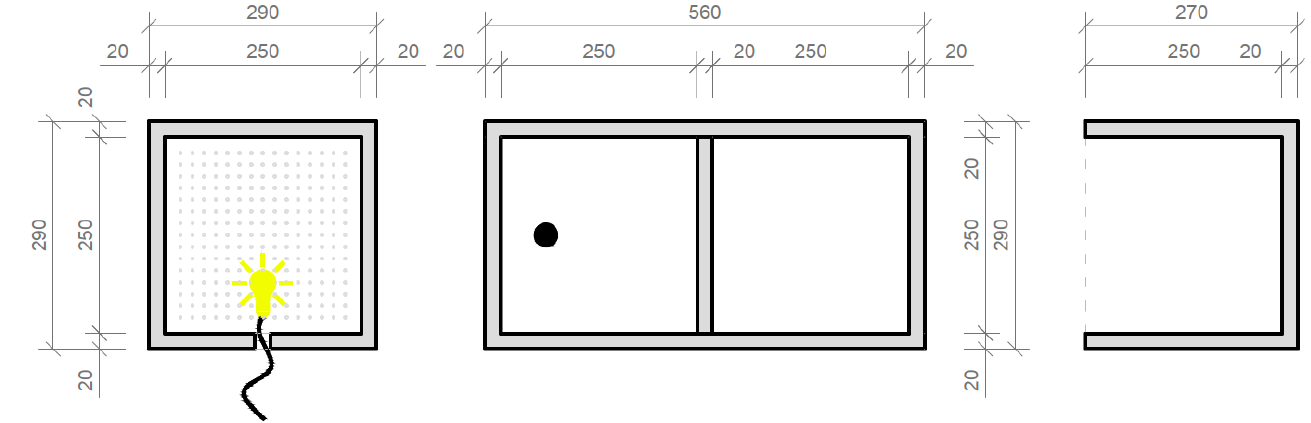
Figure 30. Down-scaled model for measurement.